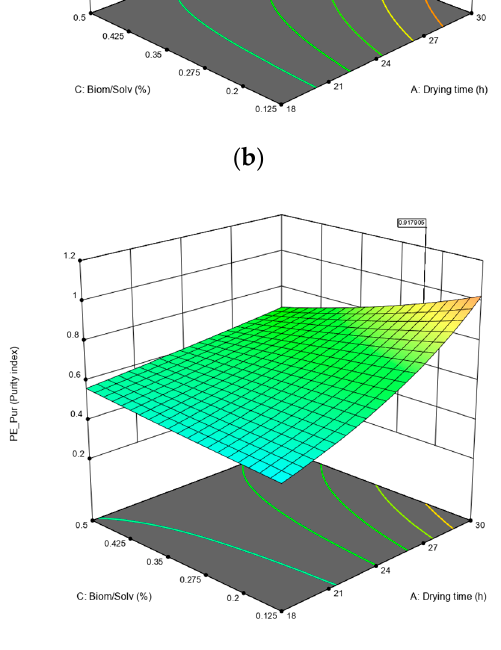
Figure 2. Surface response (three-dimensional plots) of the model equation fitted to the data on purity of C-PC ( a ), APC ( b ), and PE ( c